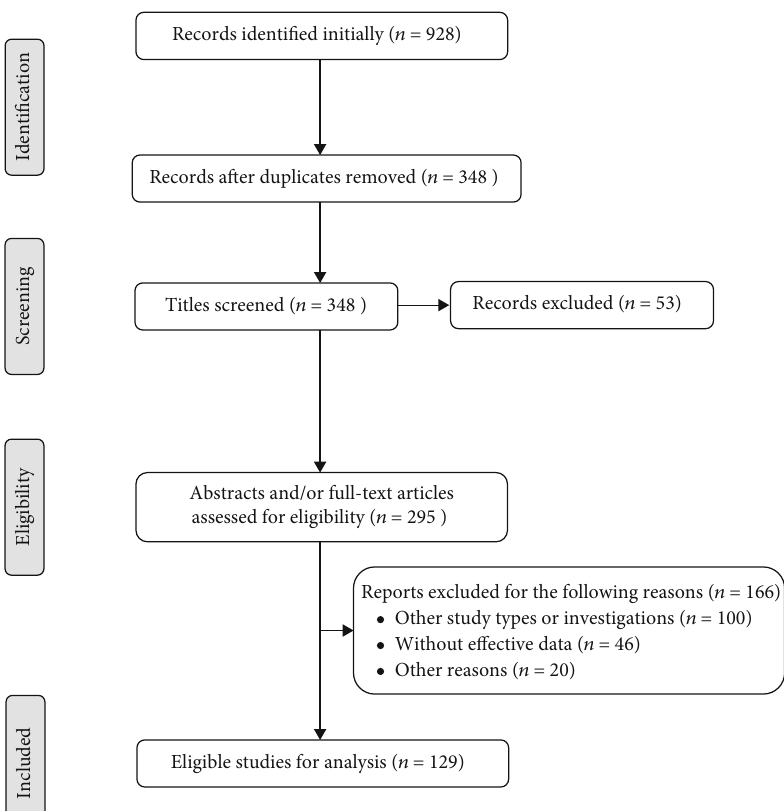
Figure 1: Flow diagram of the included studies in this